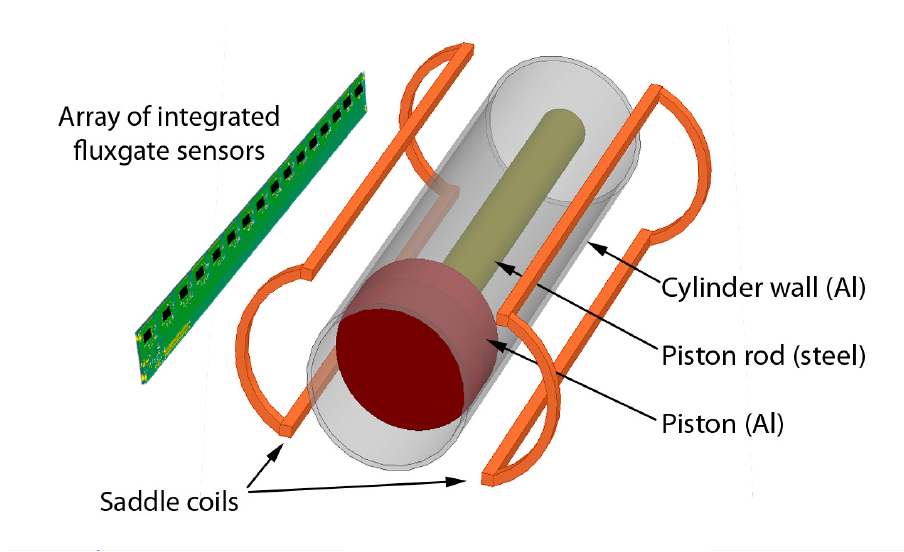
Figure 1. The position sensor consists of an array of integrated fluxgate sensors and two excitation saddle coils. The sensor is attached onto the pneumatic cylinder wall and has no moving parts.